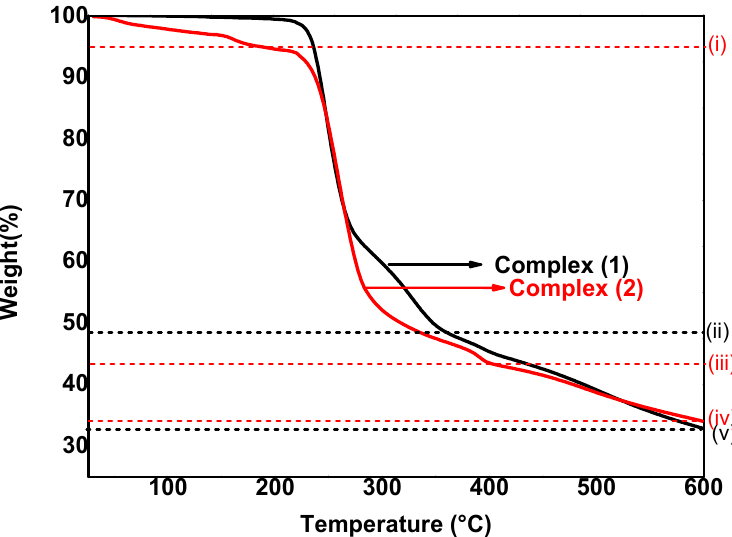
Figure 1. Thermogravimetric analysis (TGA) graph of complexes 1 and 2.